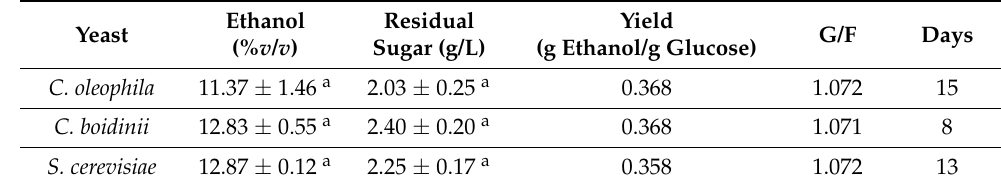
Data reported are mean values ± standard deviations. Mean values with different letters in the same column are significantly different ( p < 0.05). Table 5. Secondary compounds of sequential fermentations of Sauvignon Blanc grape juice from Casablanca Valley (Valpara í so,